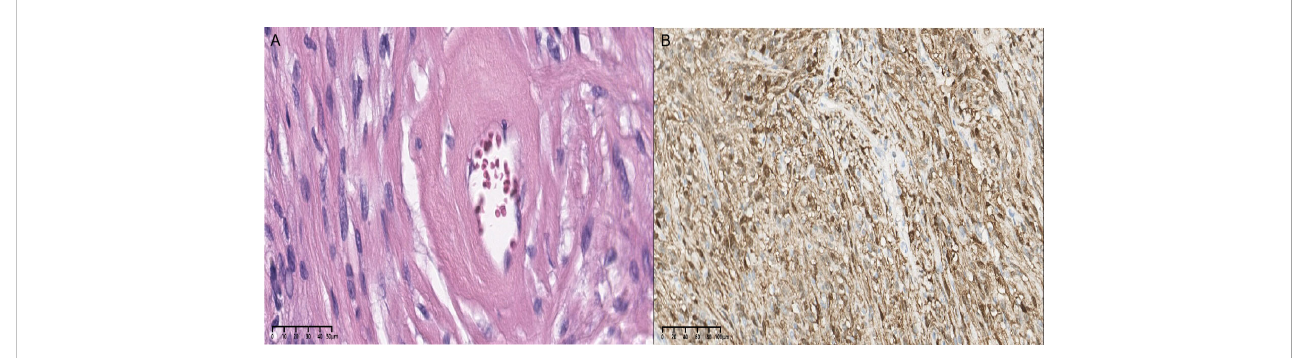
FIGURE 2 (A) Cells are regular, round or spindle shaped, with clear or eosinophilic cytoplasm (H&E×40). (B) Diffuse expression of the S-100 protein with immunohistochemistry